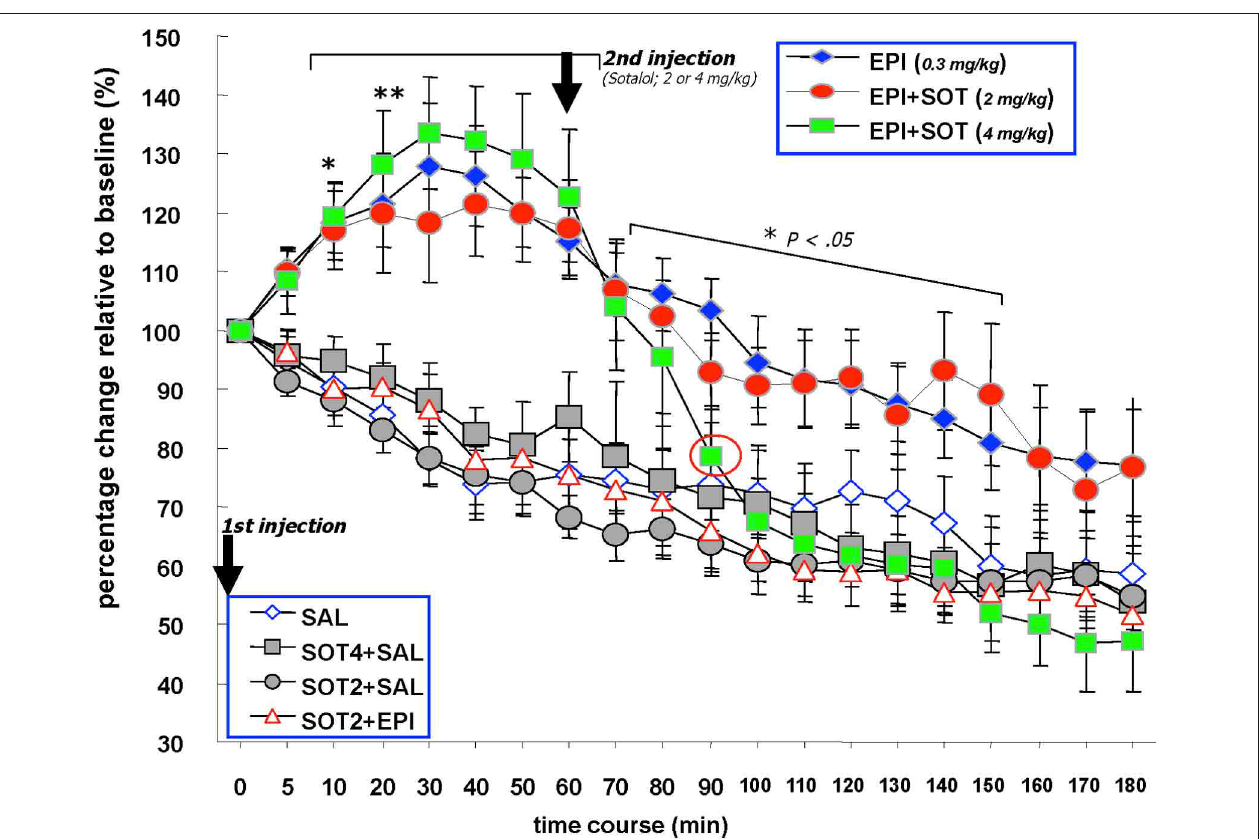
post-epinephrine injection. For the remaining time of recording, vagal activity in the EPI and EPI + SOT2 groups gradually decreased to approximately 20% above basal values. In contrast, vagal activity in the EPI + SOT4 group dropped steeply at 40min post-sotalol injectionand was reduced by approximately 50% relative to baseline at the end of recording. Neural activity recorded in the form of Millivolts from the vagus nerve in the SAL, SAL + SOT4, SOT2 + EPI, and SOT2 + SAL groups decreased over time with a reduction of approximately 50% relative to baseline at the